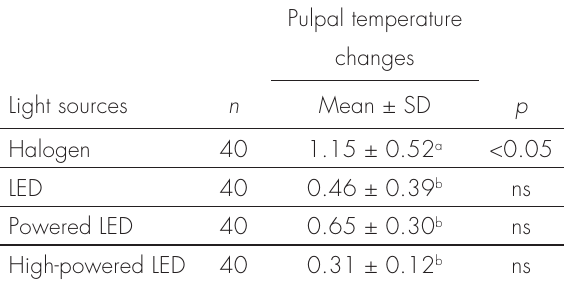
Table II. Pulpal temperature changes of light sources and statistical comparison.